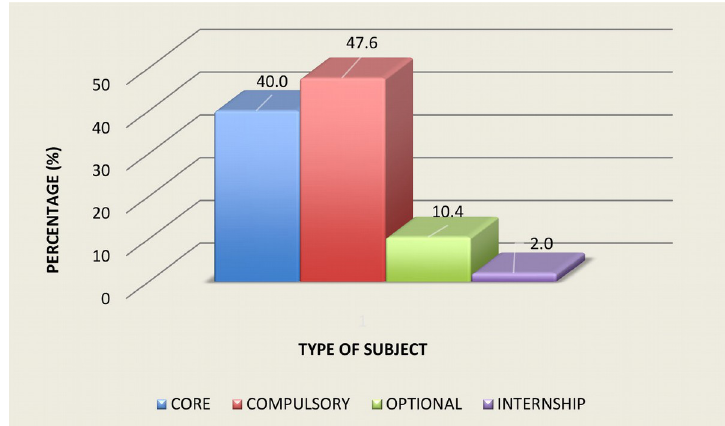
Figure 4. Percentage of subjects with content on the didactic use of cinema according to the type of